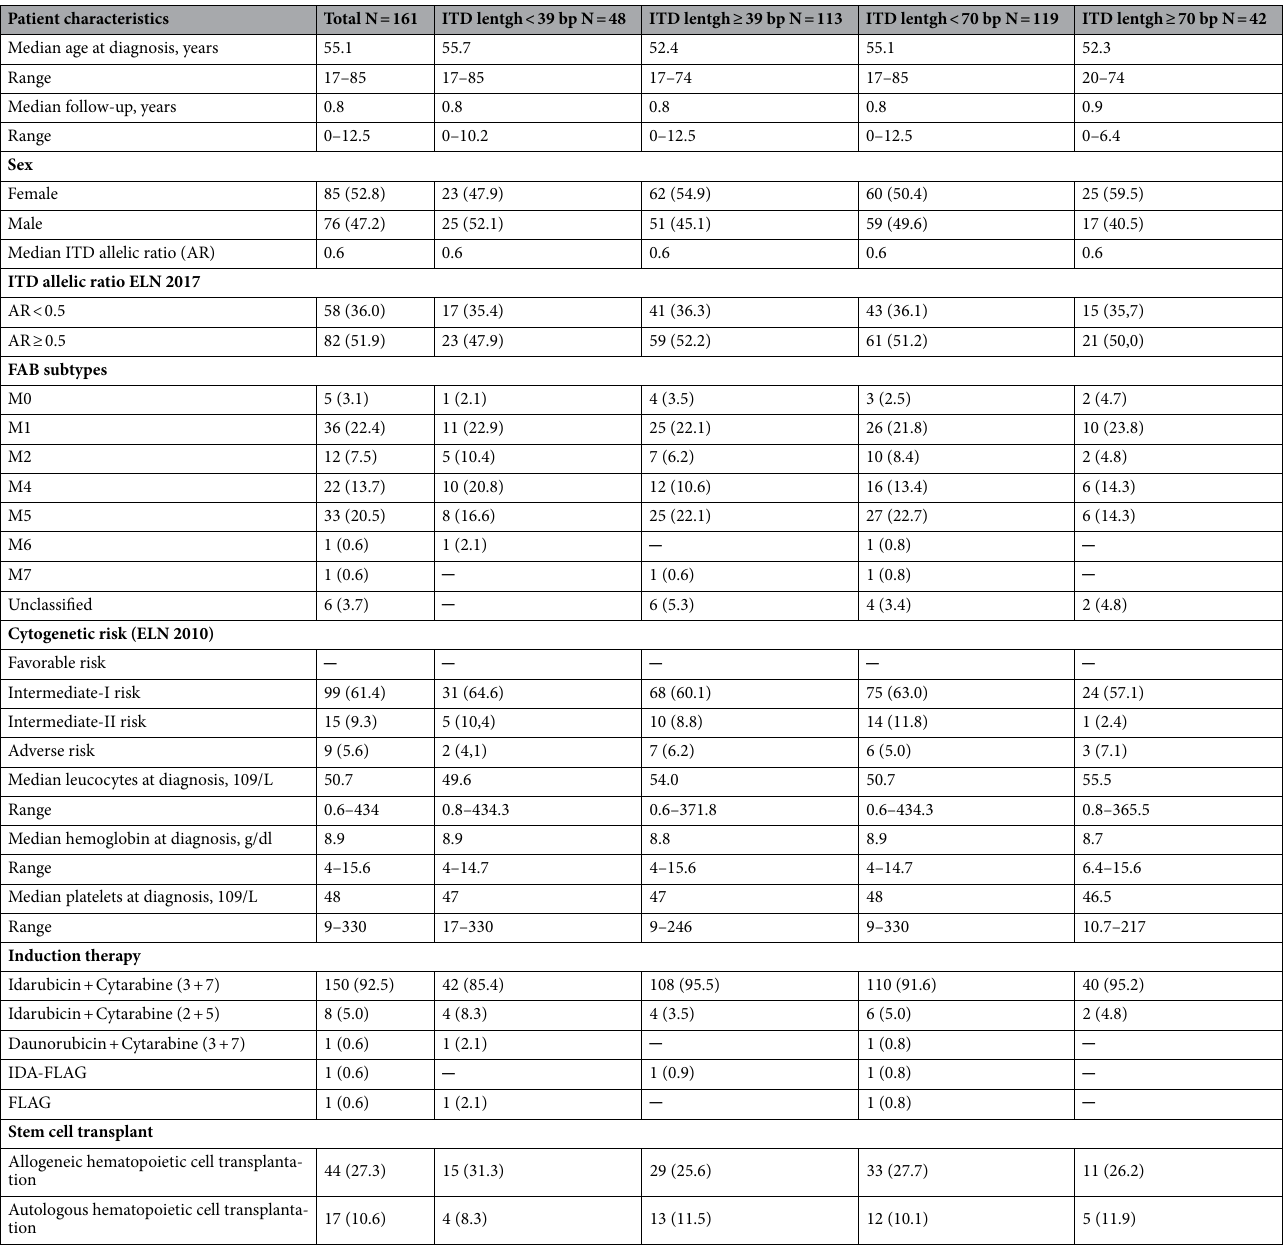
Table 1. Baseline characteristics of FLT3 -ITD AML patients treated with intensive chemotherapy regimens. FAB French American-British, ELN European leukemia